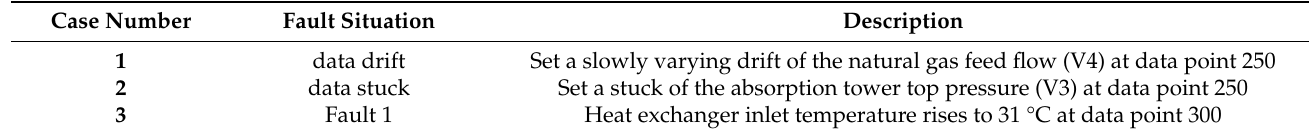
Table 5. Three faults in acid gas adsorption